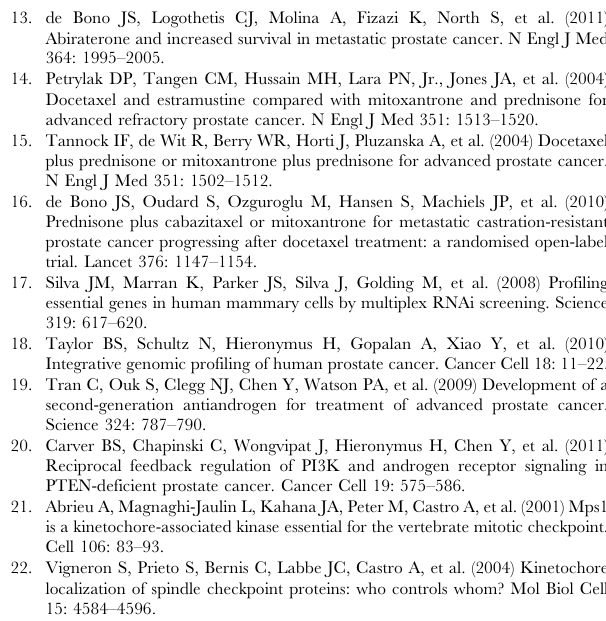
Figure S2 shRNA probes depleted in LNCaP cells. Boxplots of the relative abundance of probes in the vehicle and bicalutamide-(drug) treated LNCaP cells. Data from T =2 and T = 3 were combined for the vehicle or bicalutamide-treated boxplots. Both bicalutamide doses (0.4 uM and 1.0 uM) were also combined for the drug boxplots. The name of the shRNA probes appear in parentheses next to the target gene name above each boxplot. Figure S3 Silencing of PSMC1 inhibited PC3 cell proliferation. (A) PC3 cells were transfected with siRNAs, treated with 1 uM bicalutamide or vehicle, and the number of viable cells was measured 6 days post-treatment. Only siRNAs that inhibited VCaP cell proliferation from Figure 2 are shown. The dashed line indicates the level of growth inhibition induced by bicalutamide, for comparison. (B) Gene silencing was confirmed by RT-qPCR 6 days post-transfection of VCaP cells with the siRNA SMARTpools. Reactions were done in triplicate and normalized to RPL27 for each cDNA and then normalized to vehicle-treated NT. Standard error of the mean was calculated. Figure S4 Silencing of a subset of genes inhibited LNCaP proliferation. Candidate target genes from LNCaP screen probes that were depleted in the presence of bicalutamide were selectively targeted using siRNAs. (A) LNCaP cells were transfected with siRNAs, treated with 1 uM bicalutamide or vehicle, and the number of viable cells was measured 6 days post- treatment. Only siRNAs that inhibited LNCaP cell proliferation are shown. The dashed line indicates the level of growth inhibition induced by bicalutamide, for comparison. (B) Gene silencing was confirmed by RT-qPCR 6 days post-transfection of LNCaP cells with the siRNA SMARTpools. Reactions were done in triplicate and normalized to RPL27 for each cDNA and then normalized to vehicle-treated NT. Standard error of the mean was calculated. Bic, bicalutamide. NT, non-targeting siRNA.